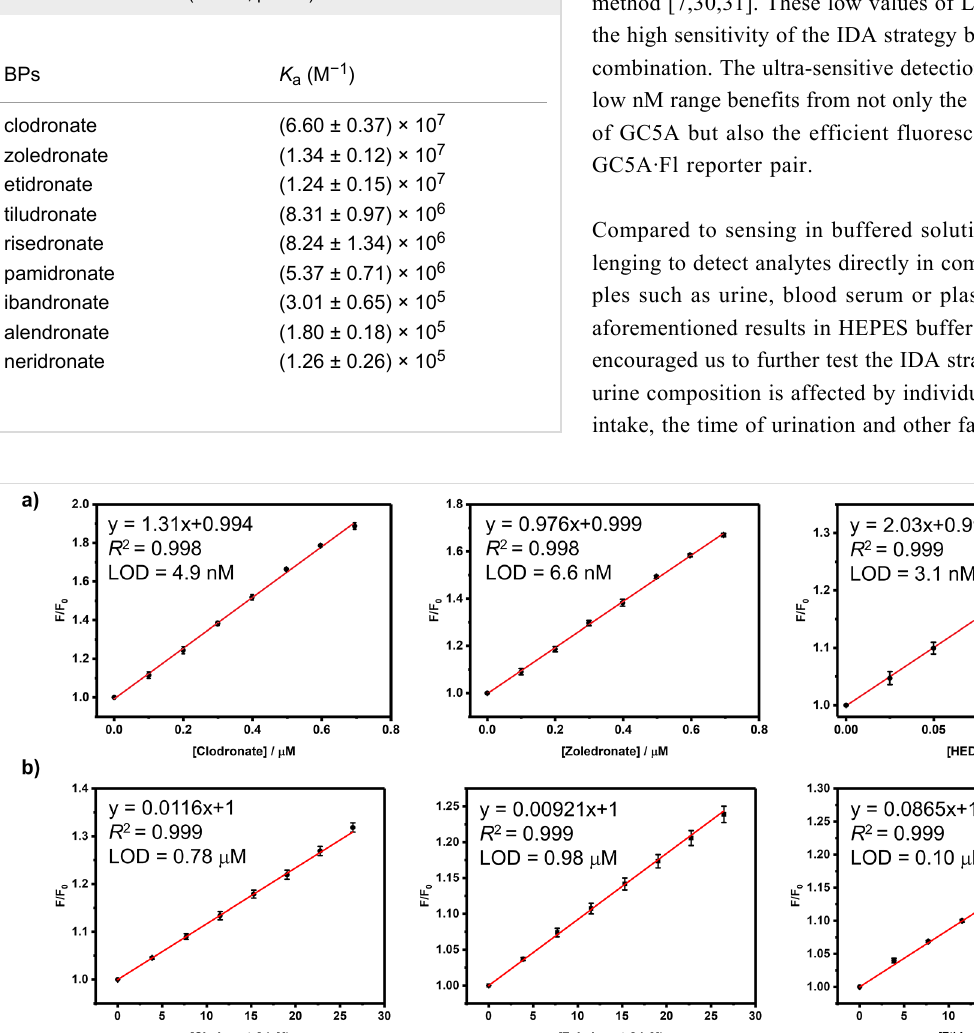
Table 1: Association constants ( K a ) of BPs and GC5A determined ac- cording to the competitive titration method. All experiments were per- formed in HEPES buffer (10 mM, pH 7.4) at 25